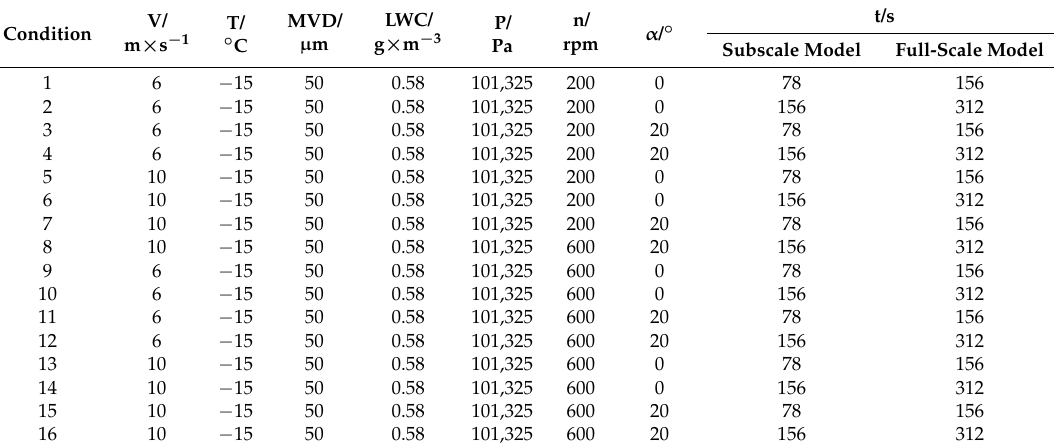
Figure 6. Schematic diagram of installed angle ( α ). Table 1. Test plane.